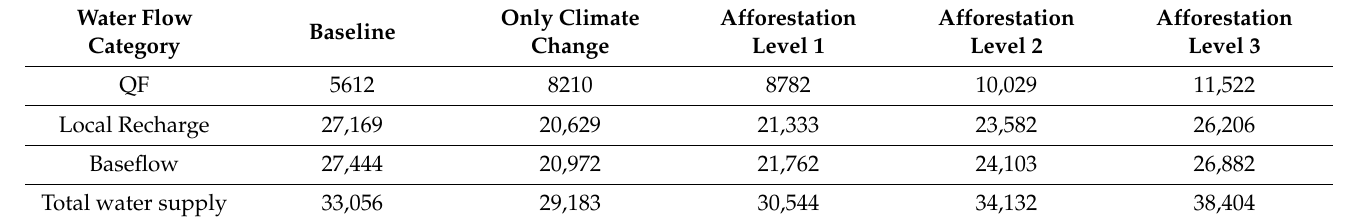
Figure 4. Spatial distribution of baseflow (B) in forest area: ( a ) baseline period (1981–2010), ( b ) climate change (2041–2070), and ( c ) climate and afforestation scenario (Level 3, 2041–2070). Table 2. Water flow statistics of baseline period and future climate and each afforestation period (million m 3 y −1 ).